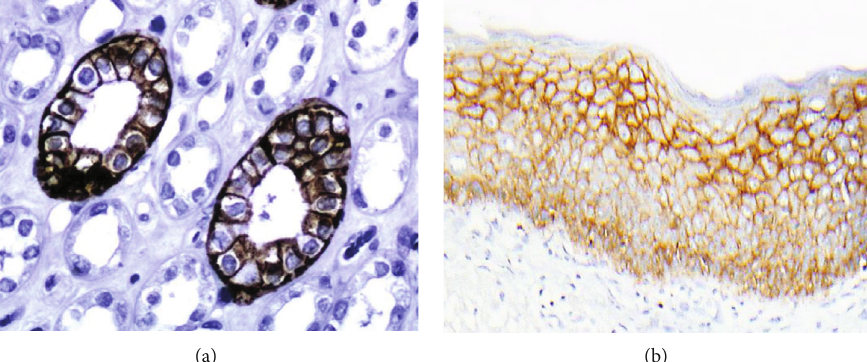
Figure 2: Immunohistochemical staining (immunoperoxidase staining in detail) of AQP3 in normal kidney and skin tissue, kidney tissue as positive control. Immunoreactivity of AQP3 is shown in the cytoplasmic membrane of collecting ducts and squamous cell (magni fi cation: 400x).